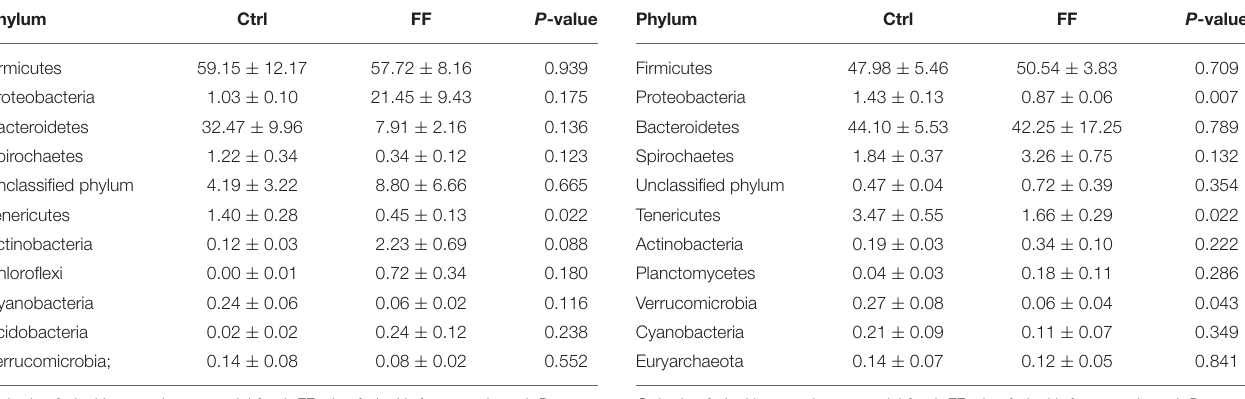
TABLE 3 | Relative abundance of microbial phylum (percentage) in the colonic mucosa-associated microbiota of pigs in the FF and control